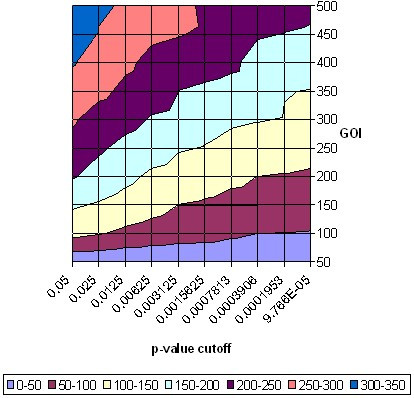
Overhead view of surface topology for the portion of the Gramene data set. Different colors represent different numbers of significant terms.